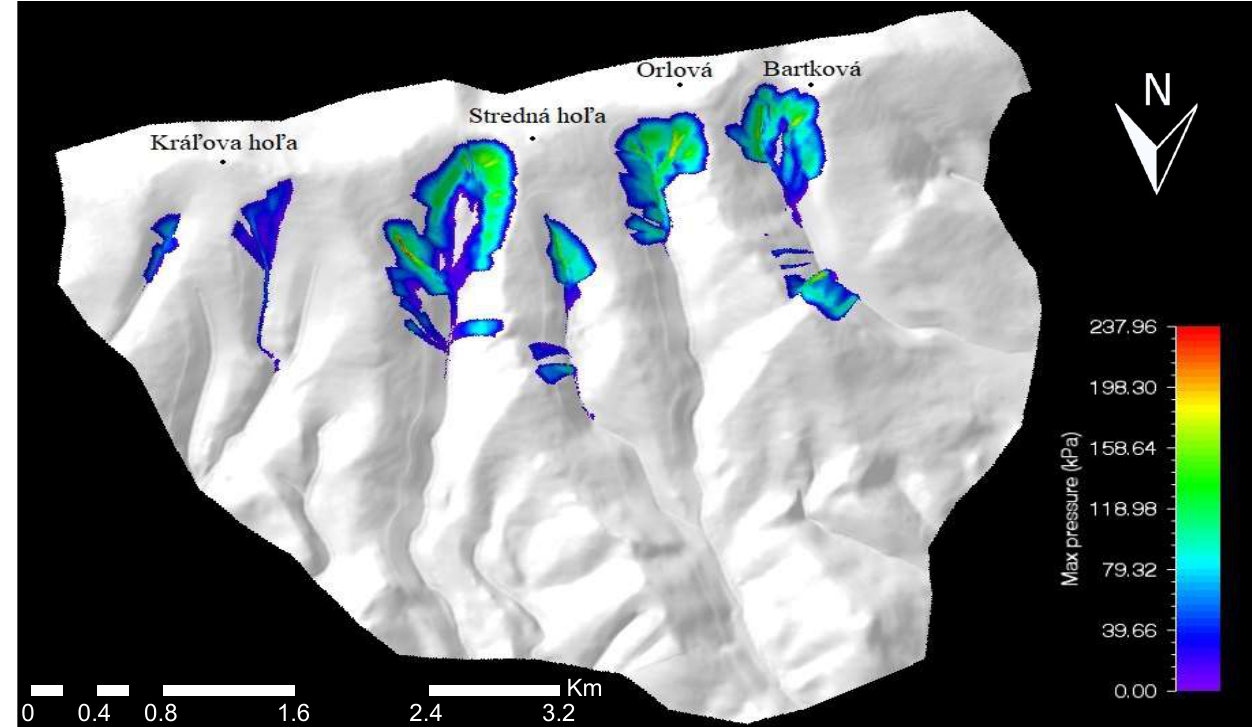
Figure 9. Maximum pressure exerted at avalanche fall (northern